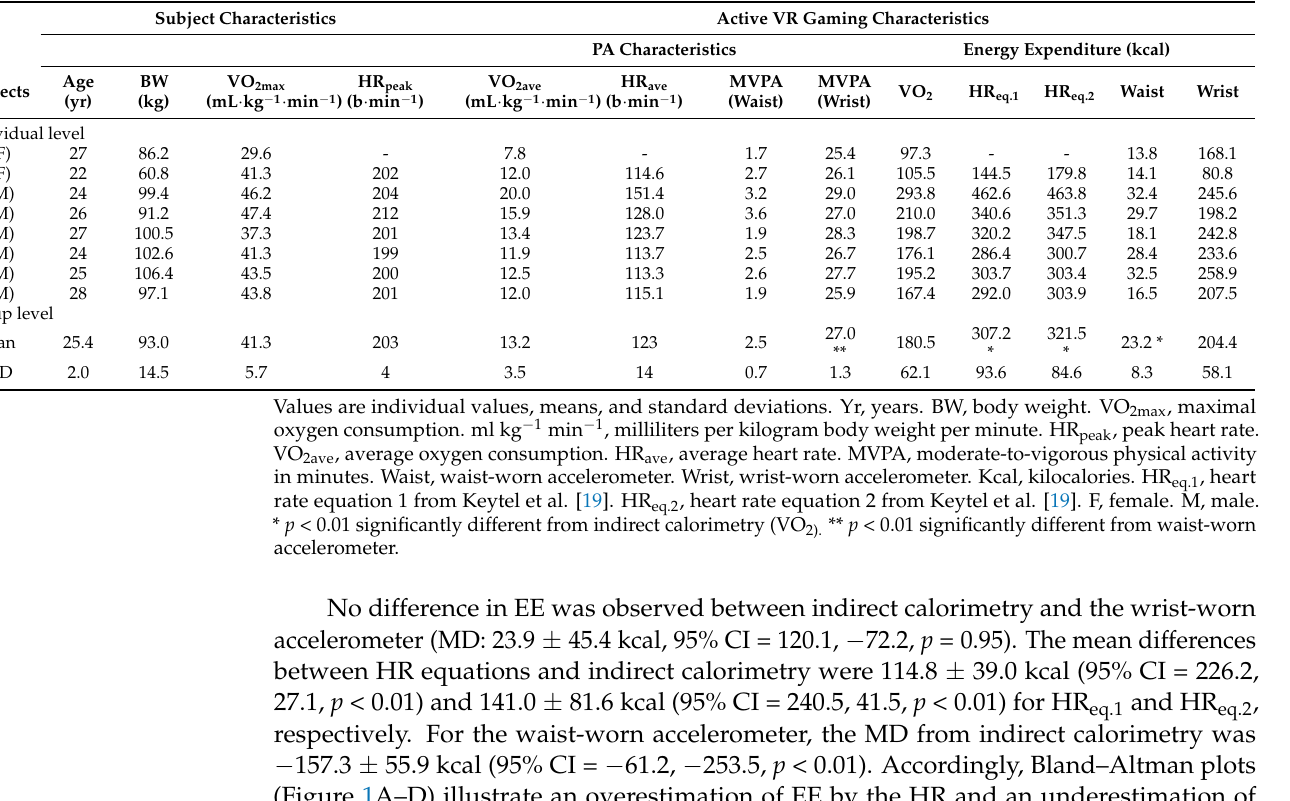
Figure 1. Bland–Altman plots: Differences in average values of energy expenditure (EE) from oxy- gen consumption (VO 2 ) and either heart rate (HR) models ( A , B ) or accelerometers ( C , D ). Mean dif- ference and 95% limits of agreement (mean ± 1.96 SD) are also displayed.